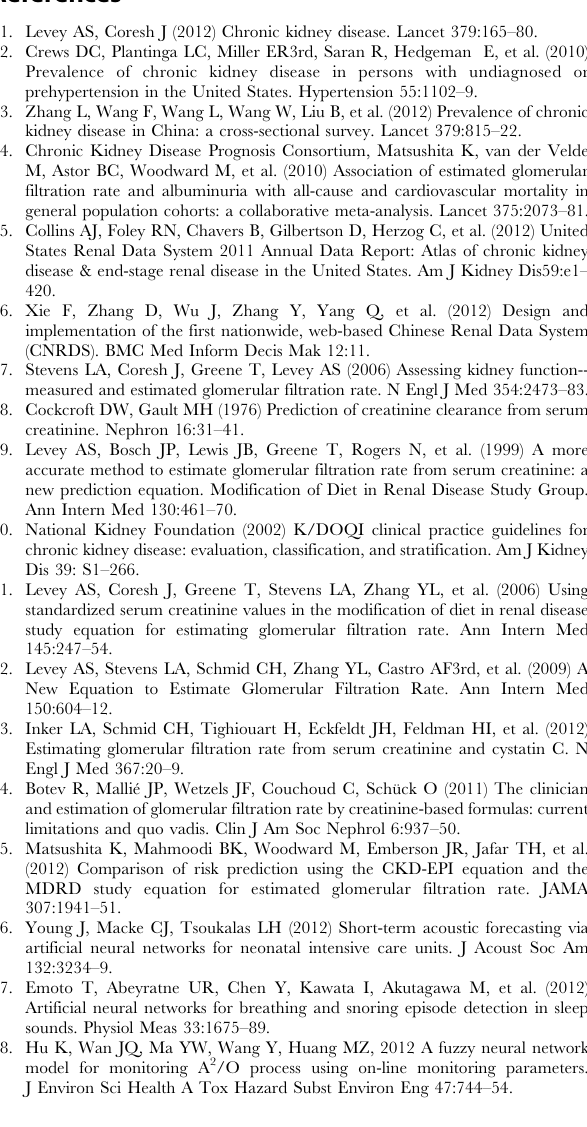
Table S15 Performance of GABP network with 1 input variable. Table S16 Overall performance of agreement between eGFR and sGFR in GABP networks with different input variables in the internal validation data set. Table S17 Overall performance of difference and accuracy between eGFR and sGFR in GABP networks with different number of input variables in the internal validation data set. Table S18 Performances between eGFR and sGFR in different stages of CKD in the external validation data set.